Question: Sum up the contents of this chart in one sentence.
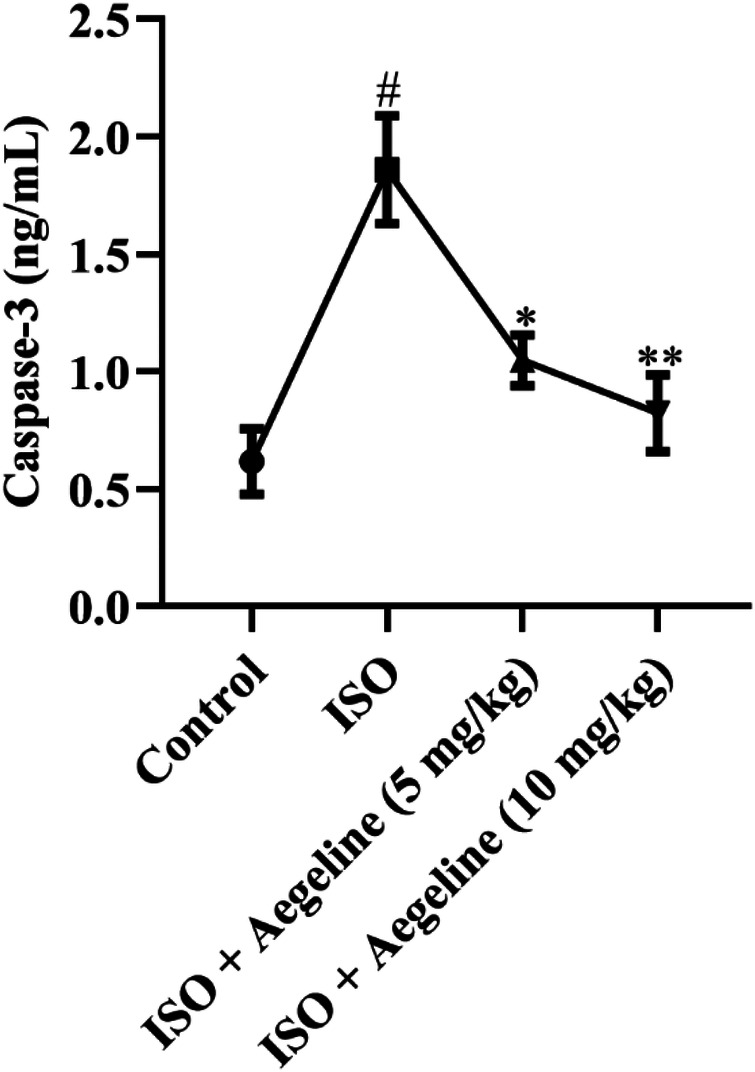
Answer: Effects of aegeline on caspase-3 levels in isoproterenol-induced myocardial infarction. Caspase-3 levels were significantly increased in the ISO group compared with the control group, indicating enhanced apoptotic activity following myocardial injury. Treatment with aegeline at doses of 5 and 10 mg/kg significantly reduced caspase-3 levels compared with the ISO group. Data are presented as mean ± SEM ( n = 6). Statistical analysis was performed using one-way ANOVA followed by Tukey’s post hoc test. # P < 0.05 vs. control; * P < 0.05 and ** P < 0.01 vs. ISO.